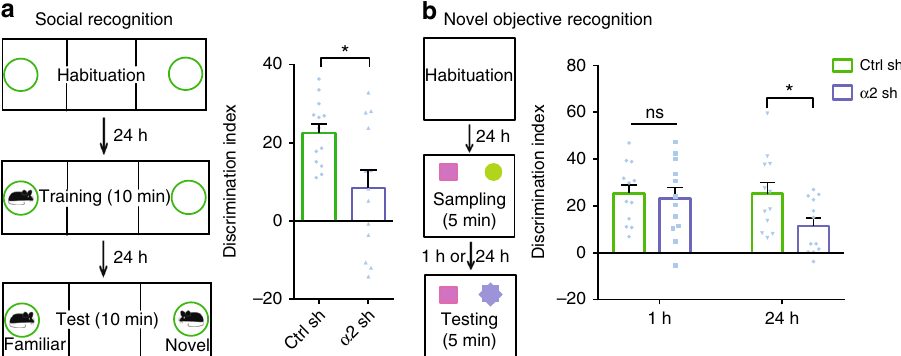
Fig. 5 Knockdown of α 2-chimaerin caused rapid decay of social memory and object recognition memory. a , b Depiction of the experimental design for social recognition and novel object recognition, respectively (left). a Decay of the 24 h social discrimination memory was induced by AAV- α 2 shRNA injection (right). * P < 0.05 (from unpaired t -test); n = 13, 13 mice. b Effects of α 2-chimaerin knockdown on 1 and 24 h object recognition memory (right). * P < 0.05 (from two-way ANOVA), n = 12, 12 mice. Data are presented as means ± SEM. Also see Supplementary Table 1.